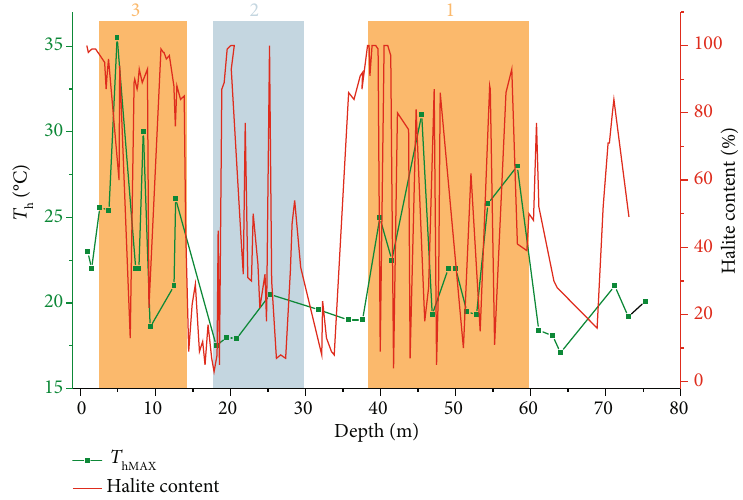
Figure 6: Relationship between halite content and ancient brine temperature in the ZK3608